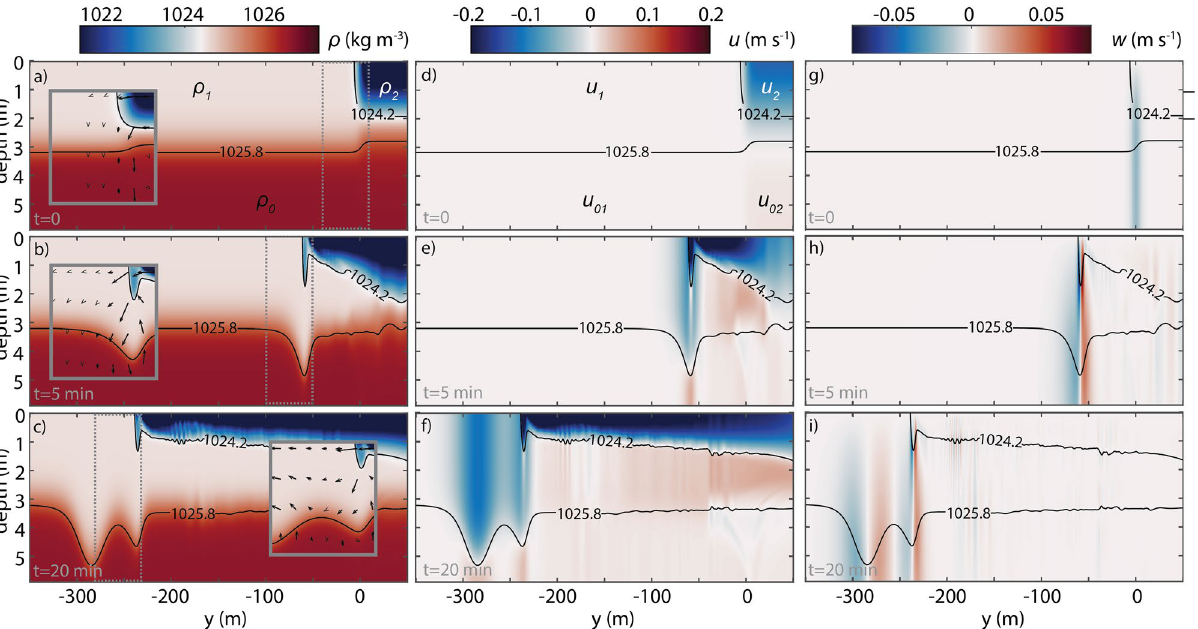
Figure 3. Numerical results. Numerical simulations of internal solitary waves generated by a subcritical plume front. ( a – c ) Density ρ , ( d – f ) eastward current u and ( g – i ) upward current w with reference density contours superimposed as grey lines. The top row ( a , d , g ) represents the model initialization ( t = 0 ) with parameters ρ 0 , ρ 1 , ρ 2 , u 0 , u 1 , u 2 , u 01 and u 02 as defined in the “Methods” section and given in Table 1. The middle row represents the moment of the first front collapse with the generation of the first pycnocline’s perturbation below ( t = 5 min ) and the bottom panel represents an entire soliton progression ( t = 20min ). For the sake of simplicity, only results from run #1 are shown. The inset on density panels ( a – c ) highlights the front evolution within the dashed boxes. Note that not all the velocity vectors are shown and w is increased by a factor of 5 for better picture legibility. Only the top 6 m are shown but the model domain is 30 m